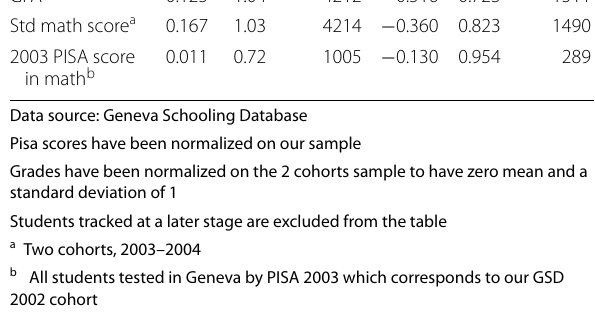
Table 3 Distribution of the number of dual VET years accu- mulated within a given three-digit ISCO occupation